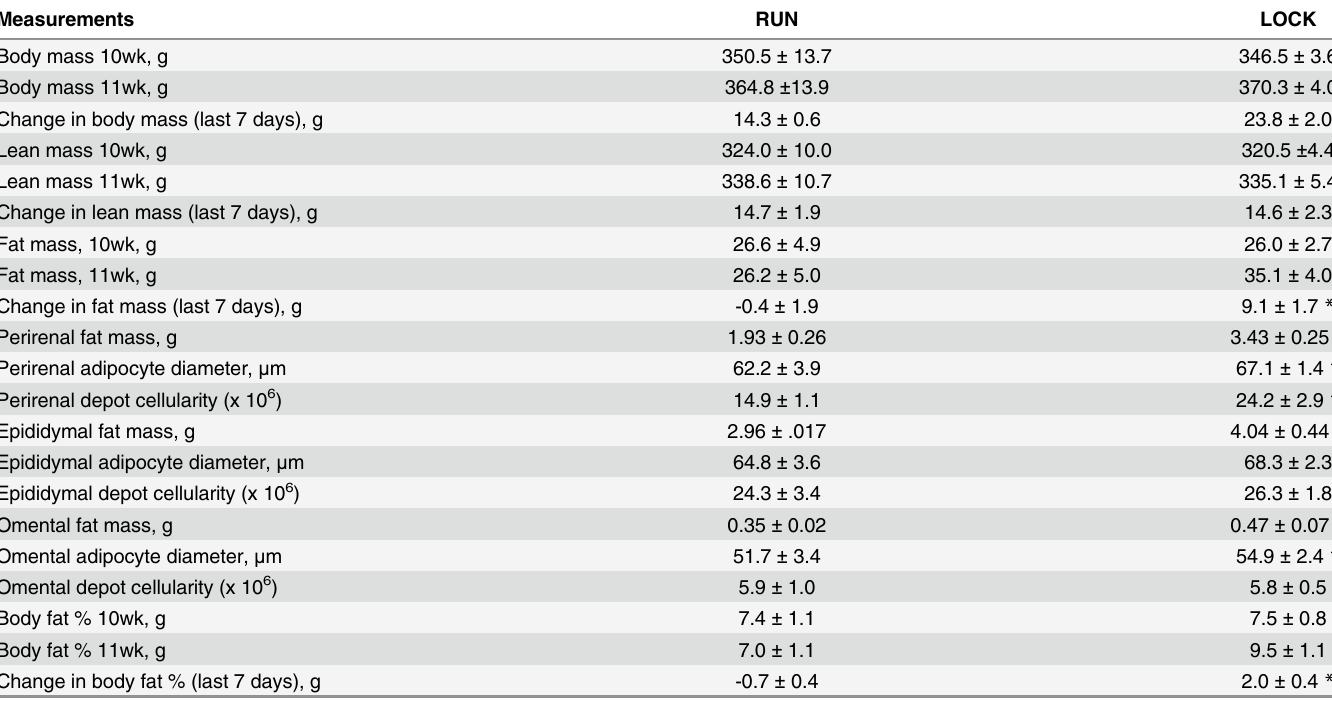
Table 2. Animal characteristics.